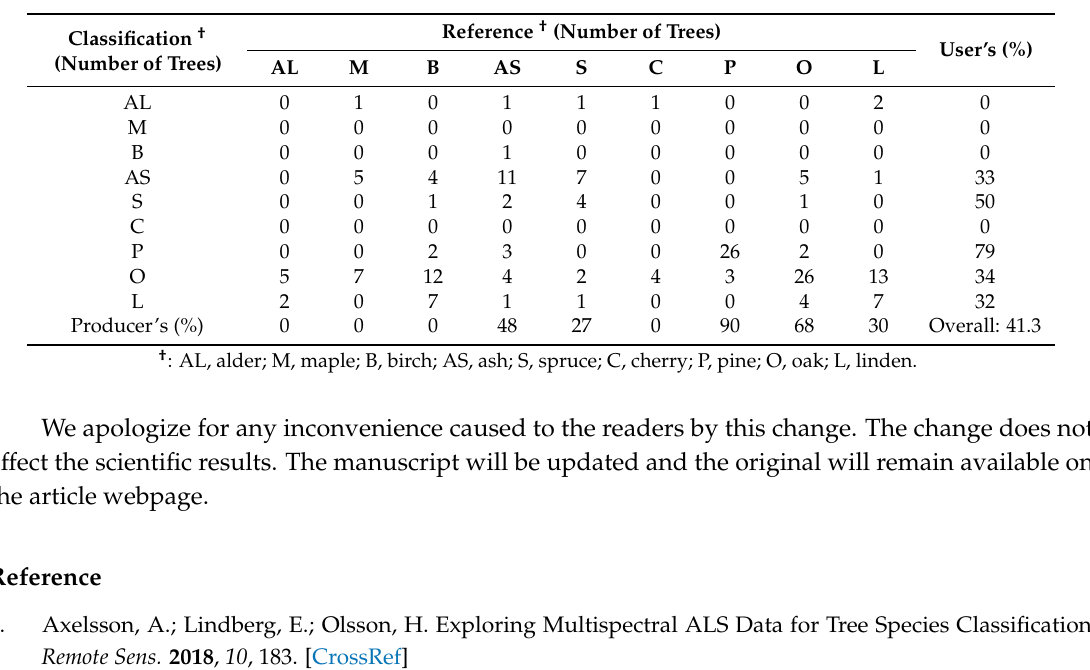
Table 8. Confusion matrix for the model created by using only the structural feature subset from the feature set resulting in the best performing model (features used are: P C 1